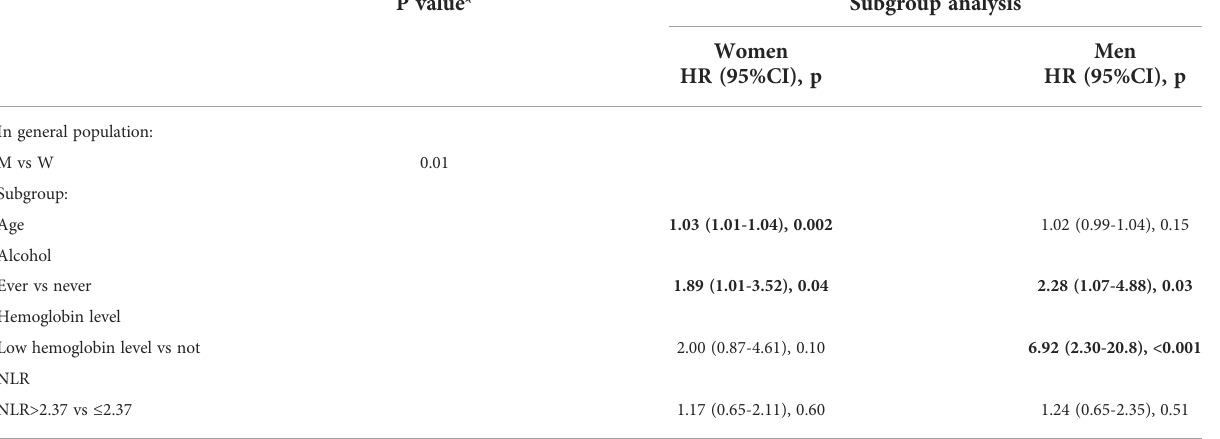
TABLE 5 Disease Free Survival (DFS) for stage I-II patients, multivariate